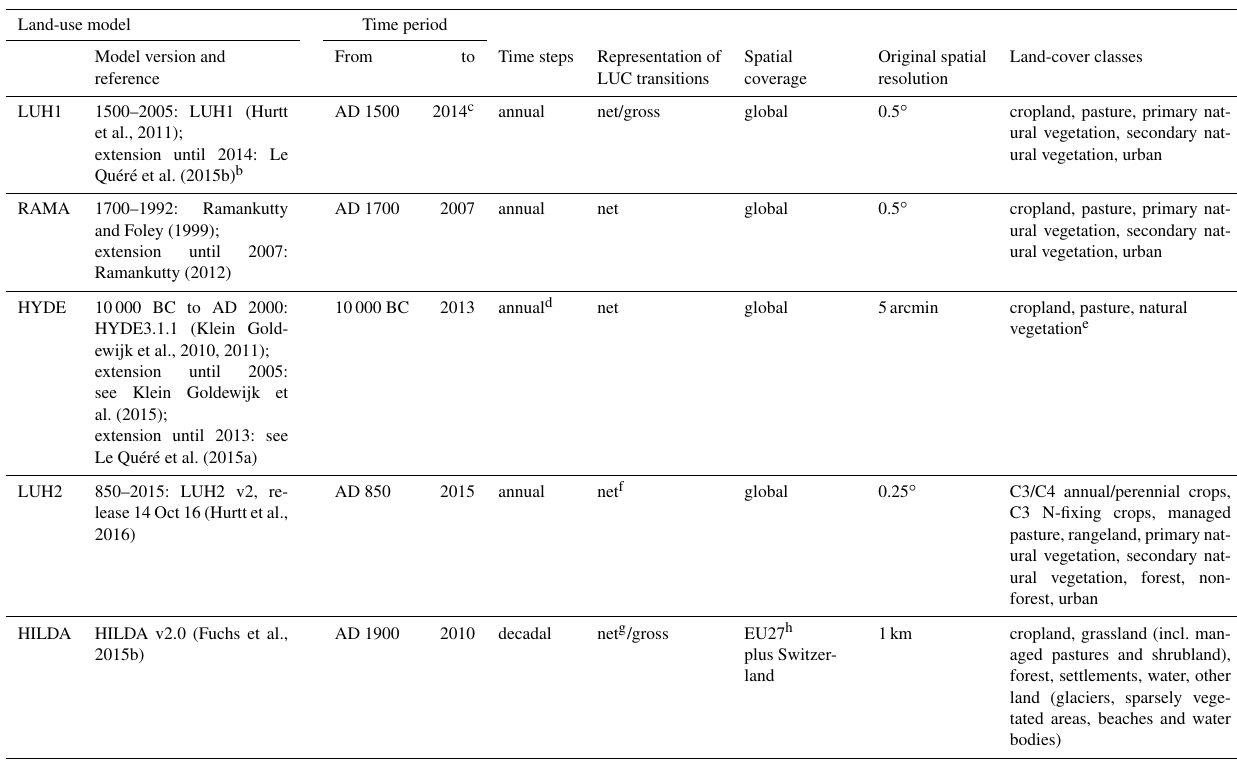
Table 1. Raw characteristics of LUC datasets used in this study a . Land-use